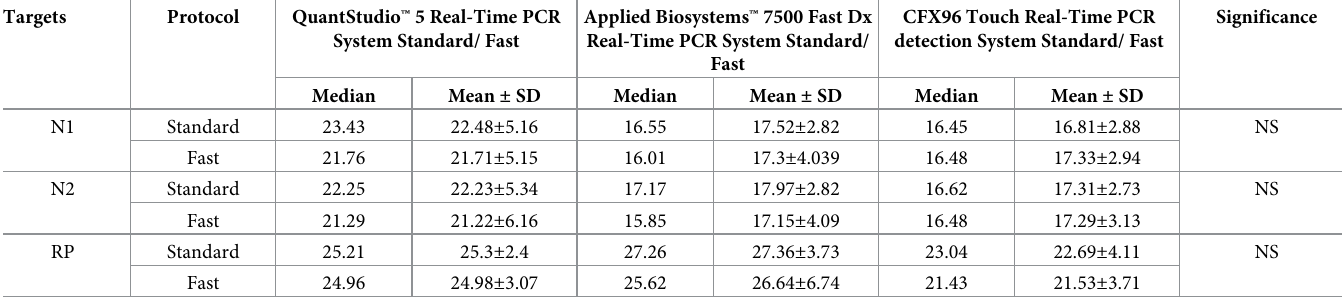
Table 5. Precision analysis of fast PCR amplification approach in terms of Ct values.